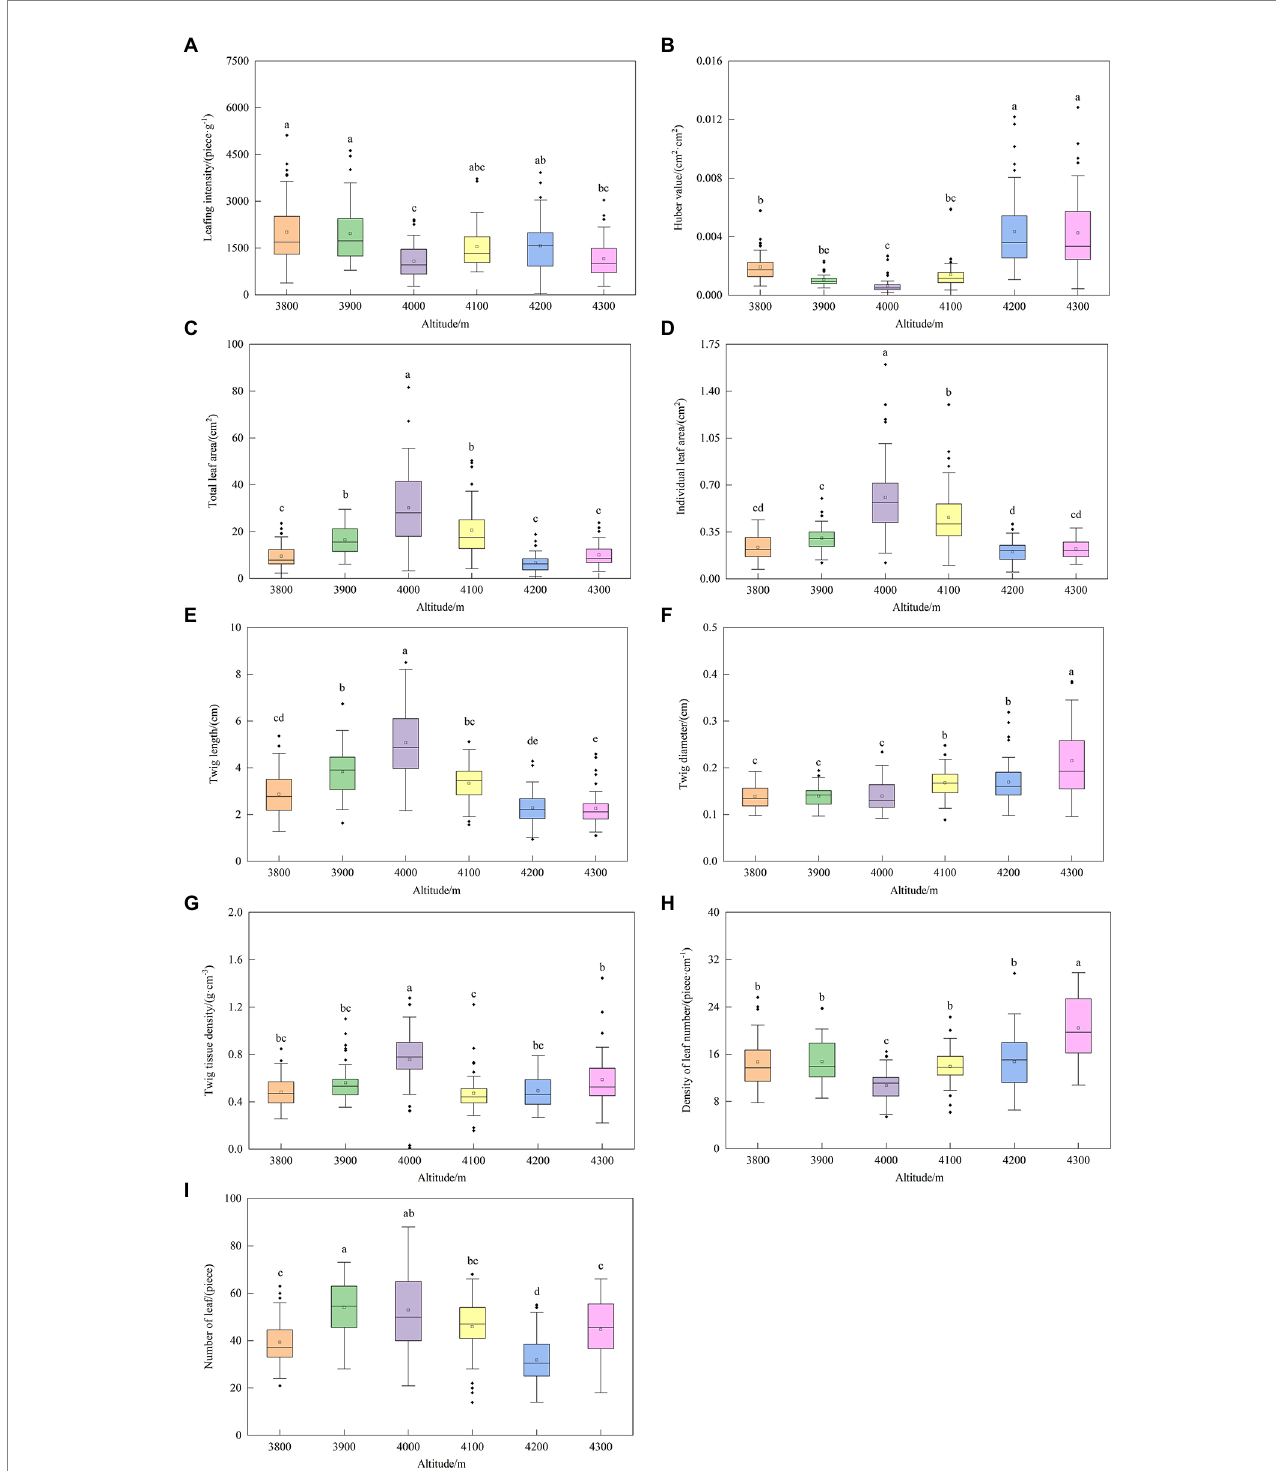
FIGURE 3 Altitudinal distribution of functional traits of current-year twigs of Abies georgei var. smithii. in southeast Tibet. (A) Leafing intensity (LI); (B) Huber value (HV); (C) Total leaf area (TLA); (D) Individual leaf area (ILA); (E) Twig length (TL); (F) Twig diameter (TD); (G) Twig tissue density (TTD); (H) Density of leaf number (DLN); (I) Leaf number in a twig (NL). Different lowercase letters in the figure indicate significant differences ( p <